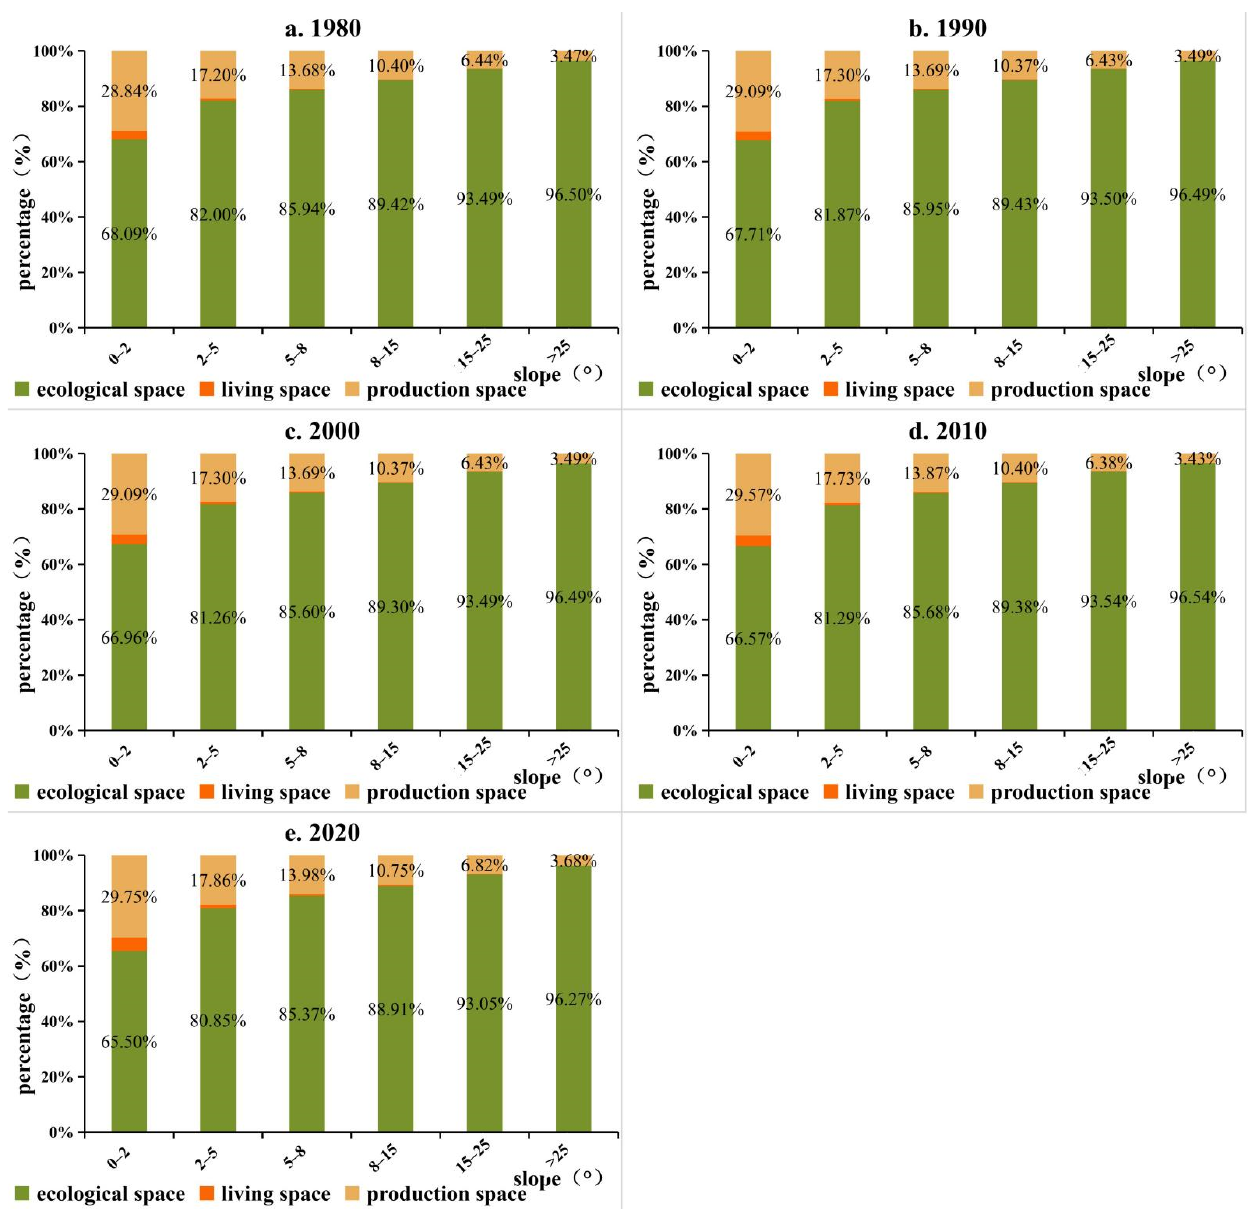
Figure 5. Changes in the proportion of PLES in different slopes in China from